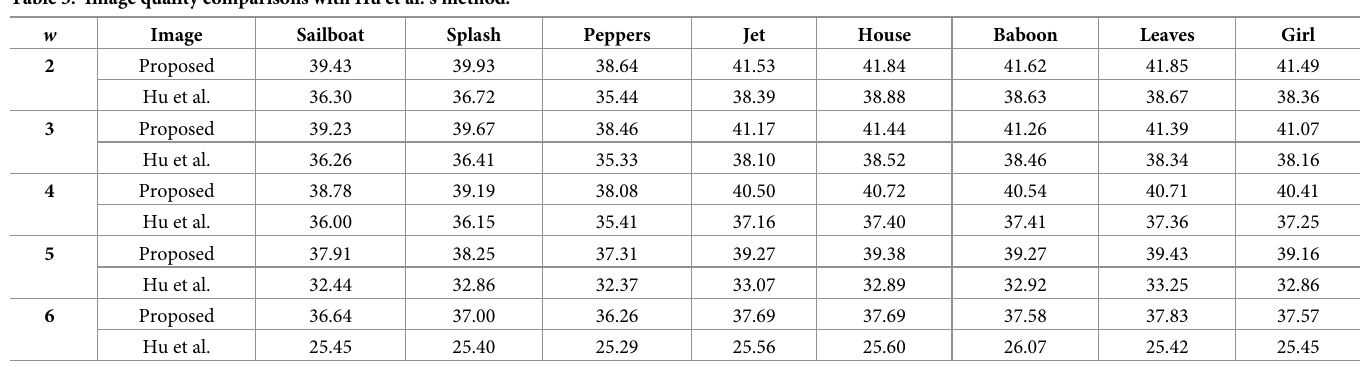
Table 5. Image quality comparisons with Hu et al.’s